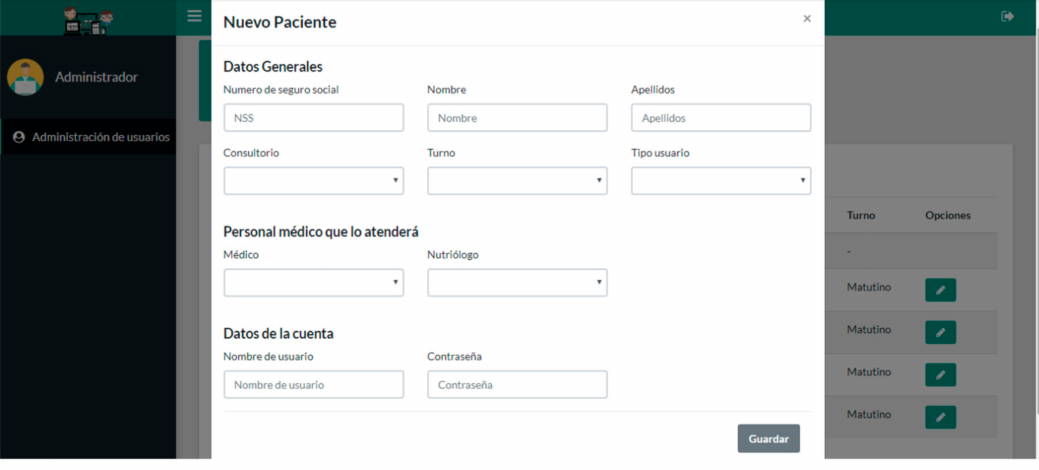
Figure 11. Administrator user interface: Service to add a user with the patient